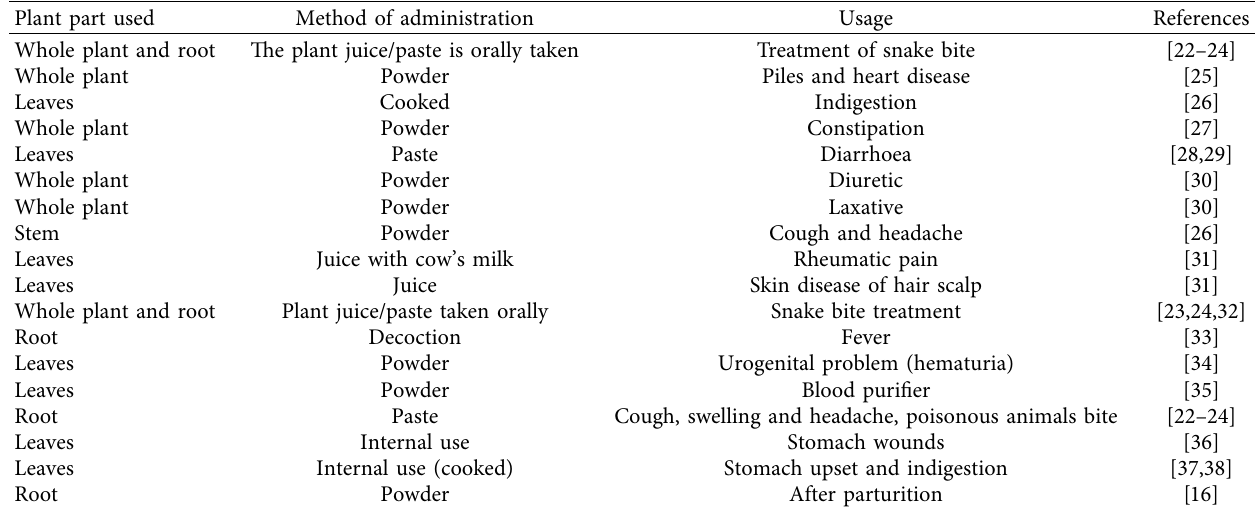
Table 1: Ethnomedicinal uses of R. hypocrateriformis